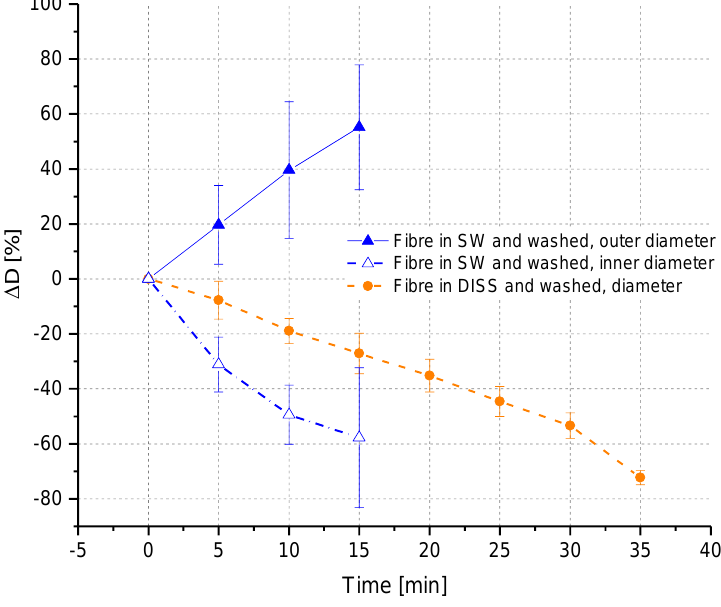
Figure 9. Changes in fibre diameter over time after washing.